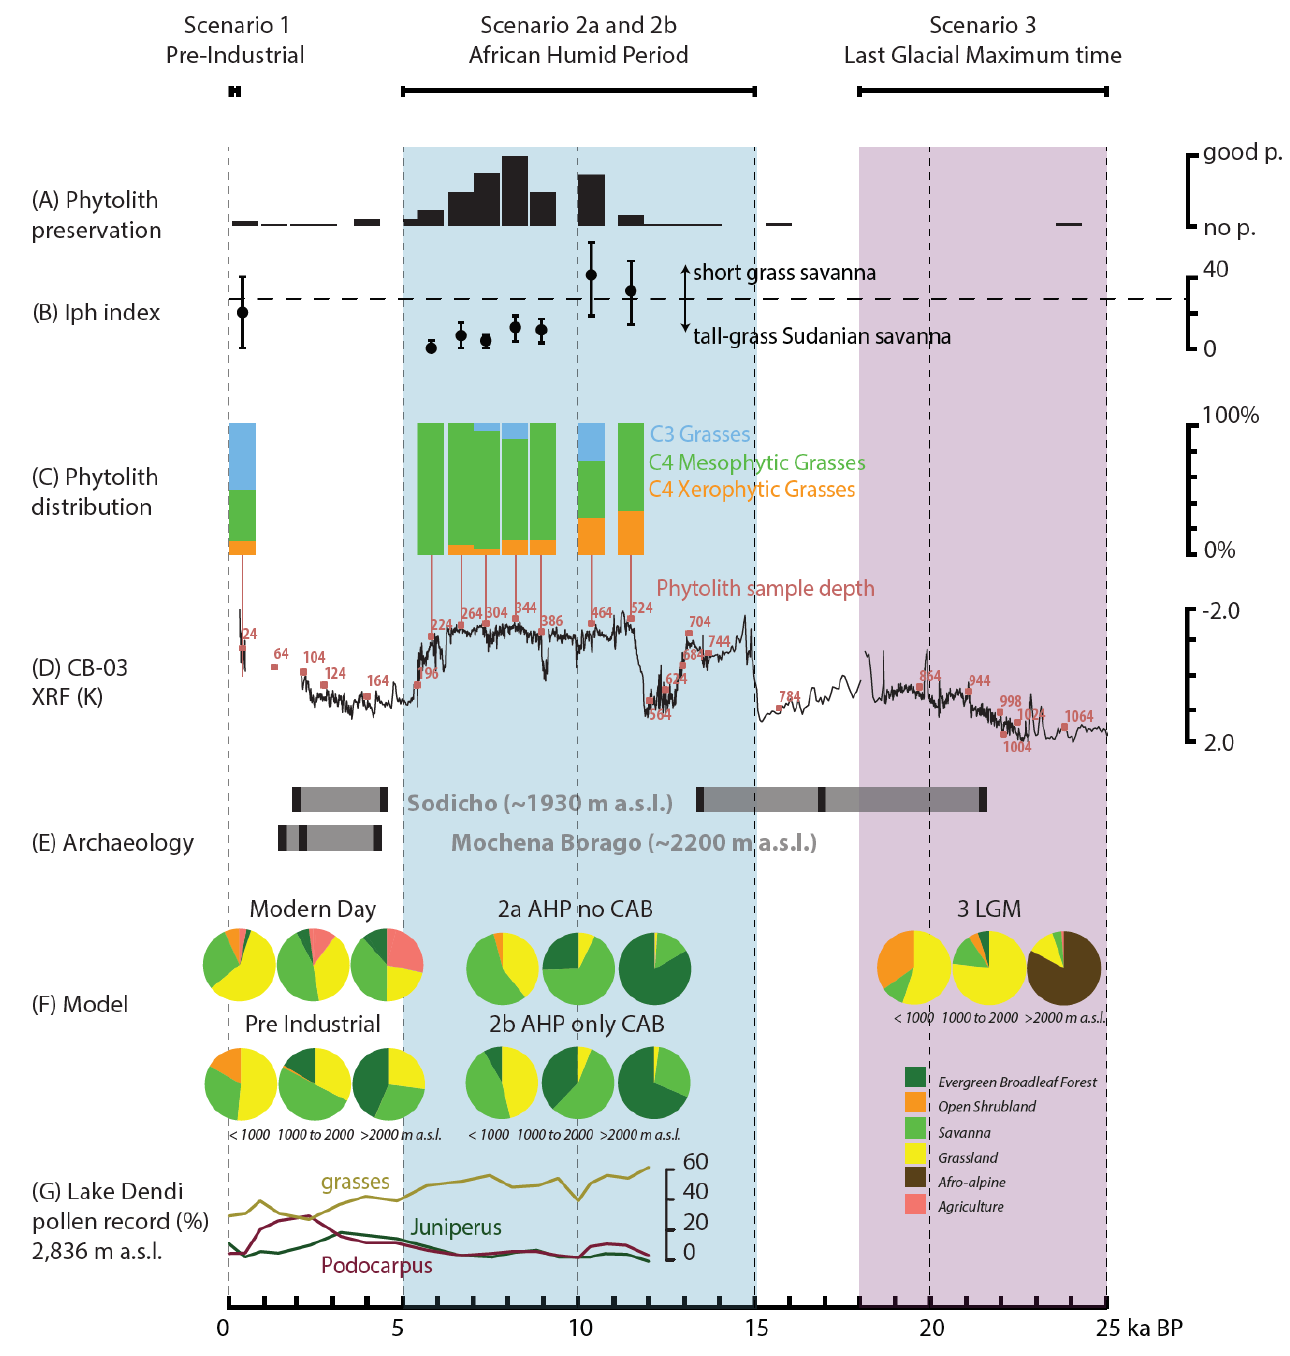
Figure 7. Proxy time series and model results: ( A ) Phytolith preservation. ( B ) Iph index. ( C ) Phytolith type distribution. ( D ) Potassium proxy record of CB-03 [33]. ( E ) Archaeological record with dated (confirmed) occupation (black) [59,60,64] and presumed occupation (grey). ( F ) Orographic strata model results with LC. ( G ) Lake Dendi pollen record summary [16].